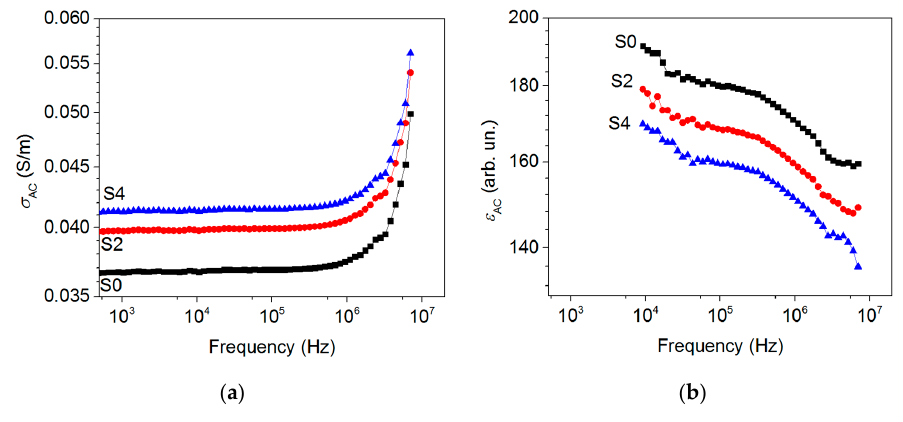
ε Figure 3. σ AC ( a ) and ε AC ( b ) of S0, S2, and S4 samples. Figure 3. σ AC ( a ) and AC ( b ) of S0, S2, and S4